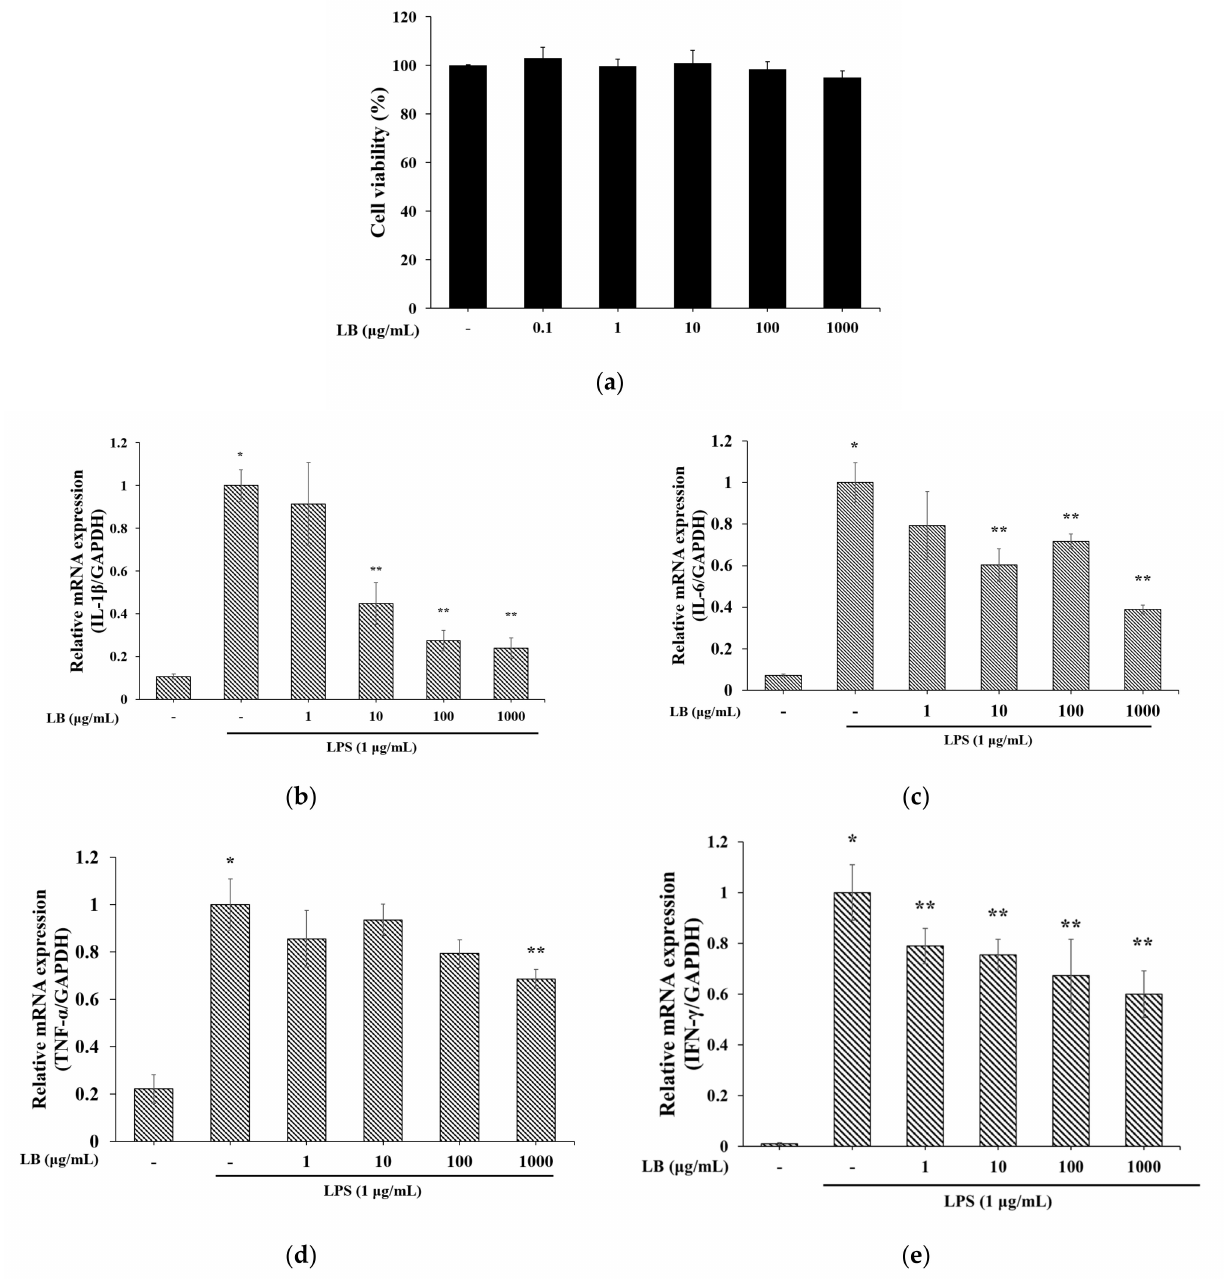
Figure 5. To determine ( a ) cell viability, an MTT assay was used. LB (1, 10, 100, or 1000 µ g/mL) did not show cytotoxicity in the peritoneal mouse macrophages. In LPS-stimulated peritoneal mouse macrophages, the LB treatments reduced the mRNA levels of ( b ) IL-1 β , ( c ) IL-6, ( d ) TNF- α , and ( e ) IFN- γ . Values are represented as the mean ± S.D. The data were analyzed by Bonferroni’s post-hoc test. * p < 0.05 versus normal group and ** p < 0.05 versus LPS stimulation-only